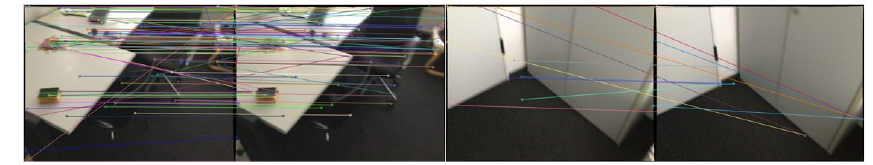
Figure 7. Matching result from SIFT(2D).